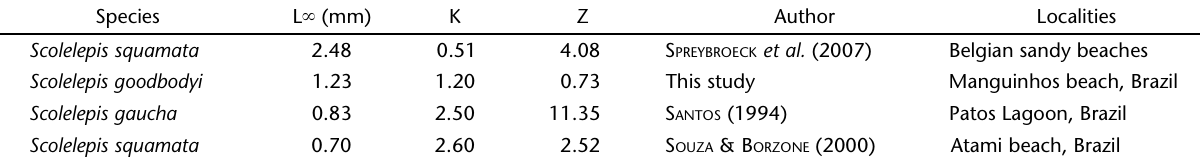
Tab Table V. Growth parameters of different Spionidae species. L (cid:2) asymptotic length; K growth constant; Z mortality rate.